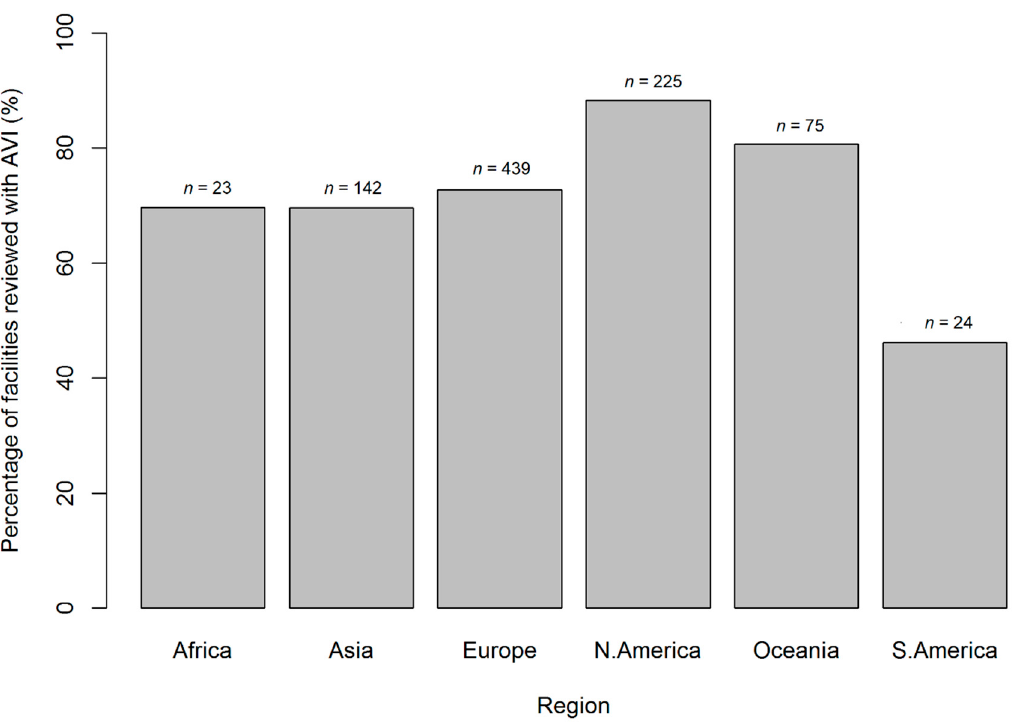
Figure 5. Percentage of facilities with an advertised AVI split by regions (number above each bar indicates the actual number of facilities with an AVI). A significant difference between the observed frequency of facilities with AVIs per region and those expected (by an even distribution weighted by the number of facilities surveyed per region ( χ 2 = 13.5, df = 5, p = 0.019)), with North America and Oceania having a higher frequency of AVIs than expected.